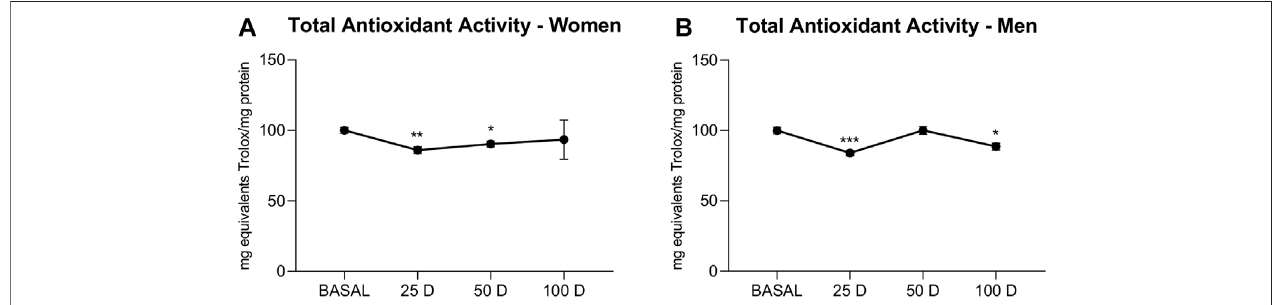
FIGURE 3 | TAA (expressed as mg Trolox (Tx)/g prot) of plasma extracted from women (A) and men (B) at baseline (BASAL), 25 days (25 D), 50 days (50 D) and 100 days (100 D). Data are mean±SEM. *BASAL vs. 25, 50 and 100 D. The number of symbols marks the level of signi fi cance: one for p < 0.05, two for p < 0.01 and three for p <